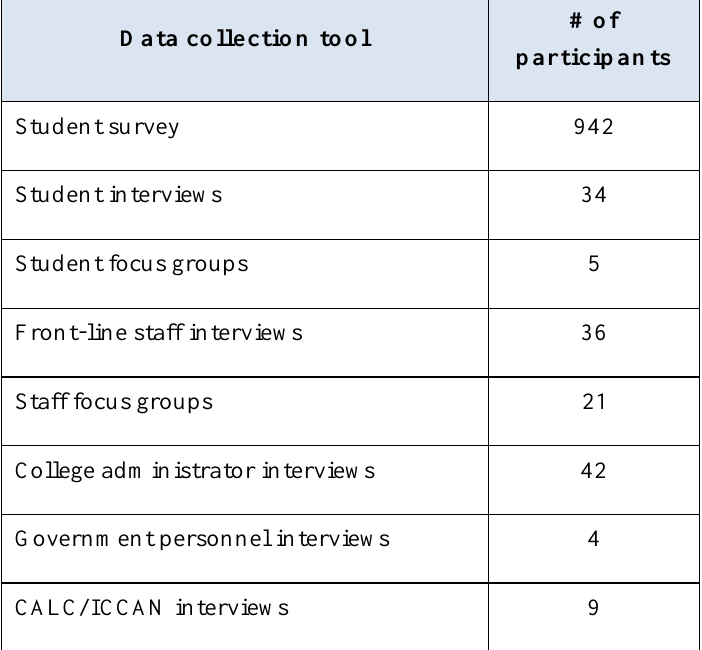
Data collection